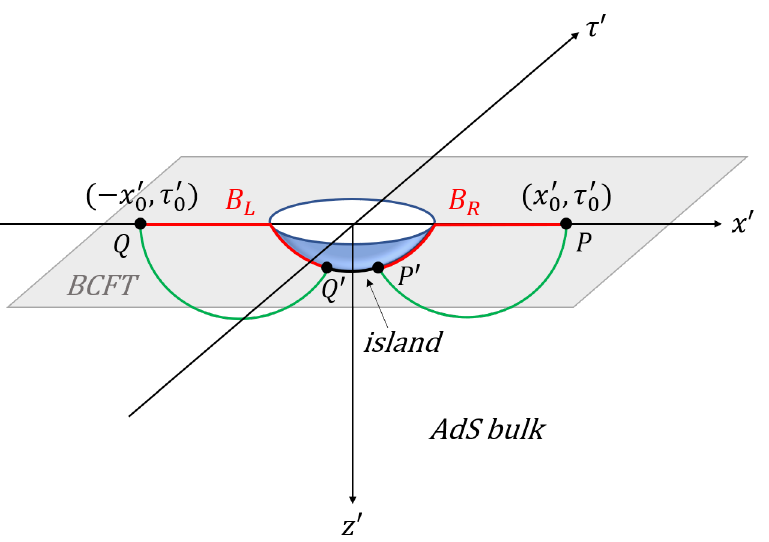
Figure 12. The disconnected phase of the extremal surface. In this phase, the extremal surfaces of the black hole region are two disconnected geodesics. The left and right parts of the black hole are naturally separated by an island appearing in the